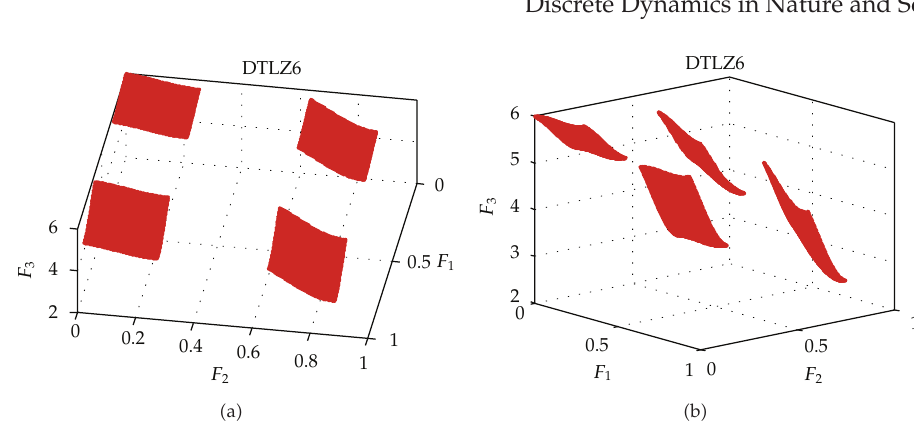
Figure 19: The true Pareto optimal front on